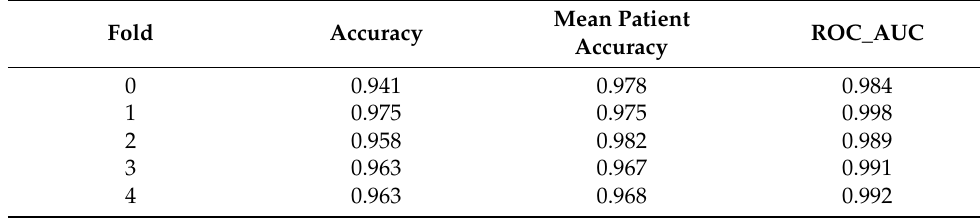
Table 3. Classification of PillCam Crohn CE images by a combined